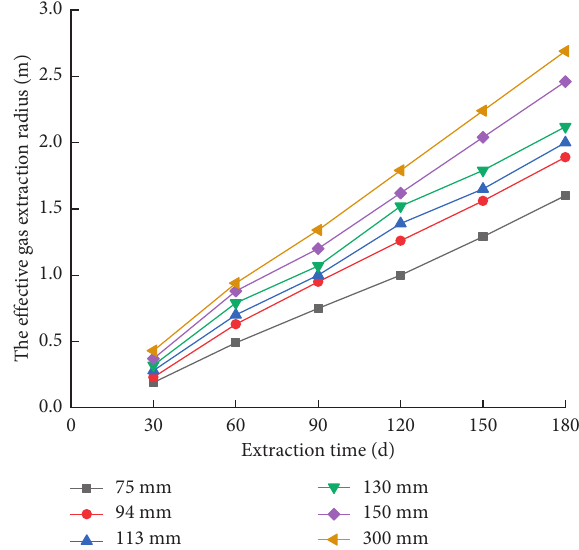
Figure 5: The variation of effective radius with extraction time under different